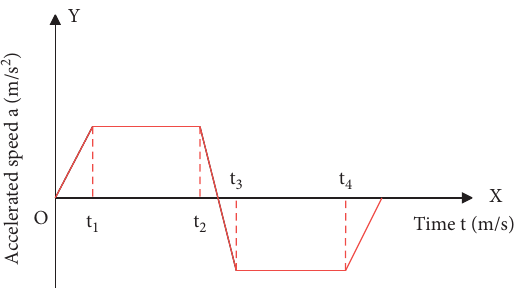
Figure 3: Image of the route planning method based on trapezoidal